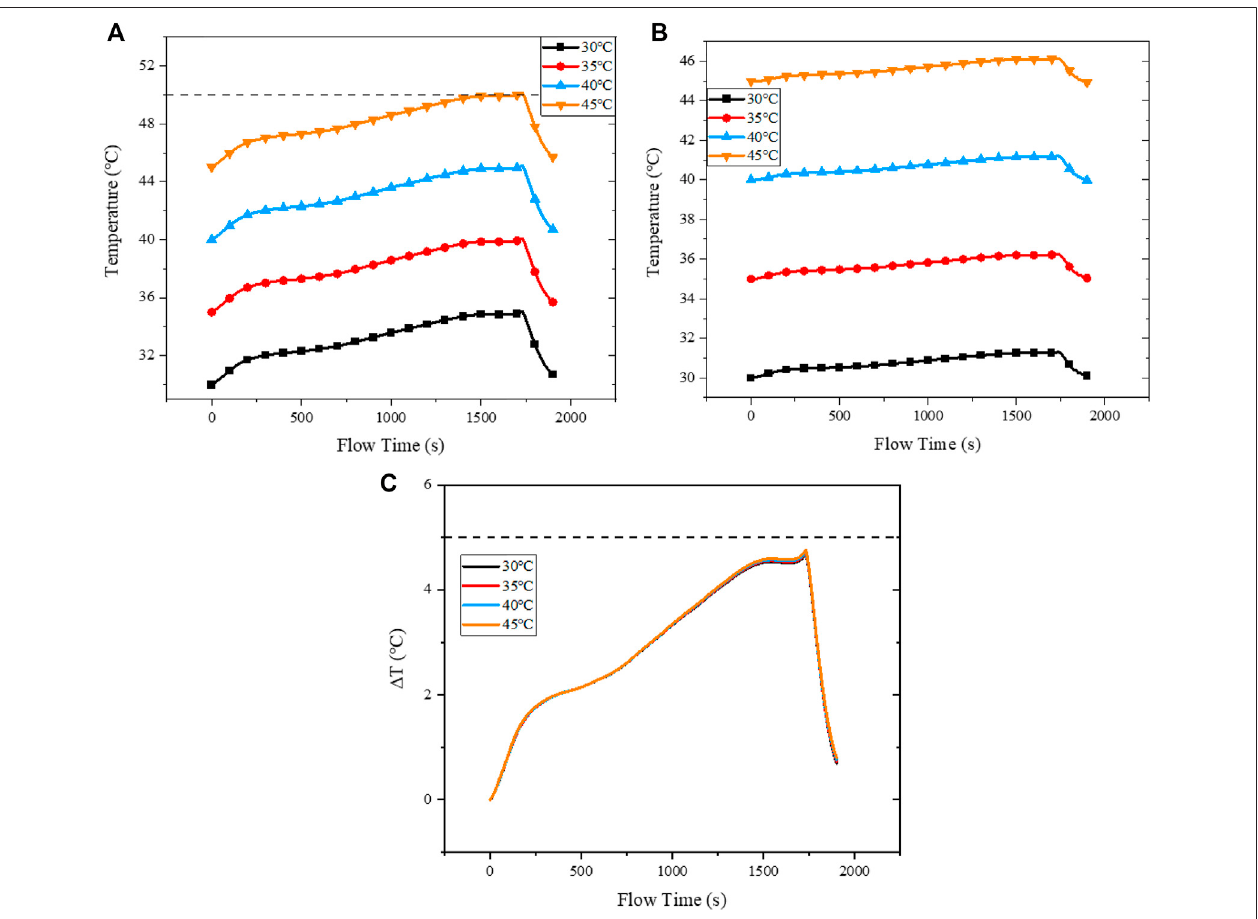
FIGURE 9 | Comparison of different inlet temperatures: (A) temperature of the battery pack; (B) temperature of the outlet water fl ow; (C) maximum temperature difference of the battery pack.